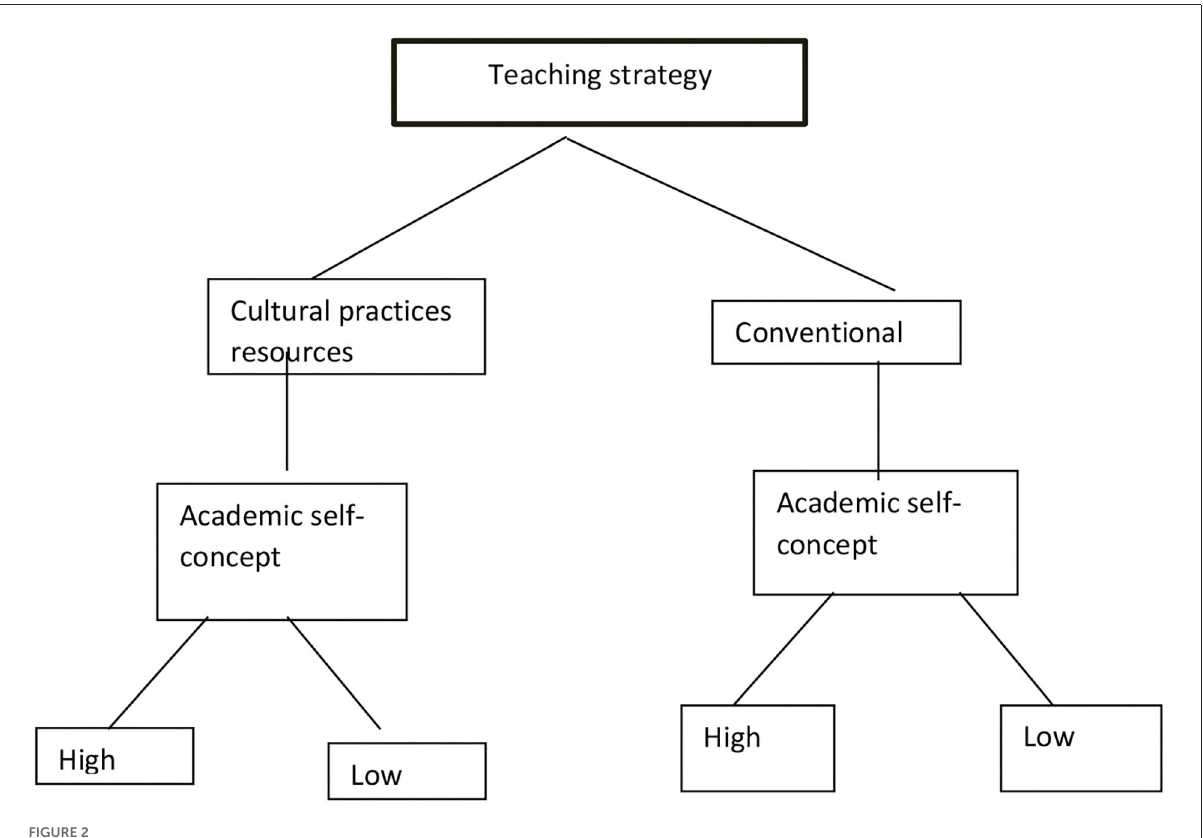
FIGURE2 Picture a factorial design (2 × 2).